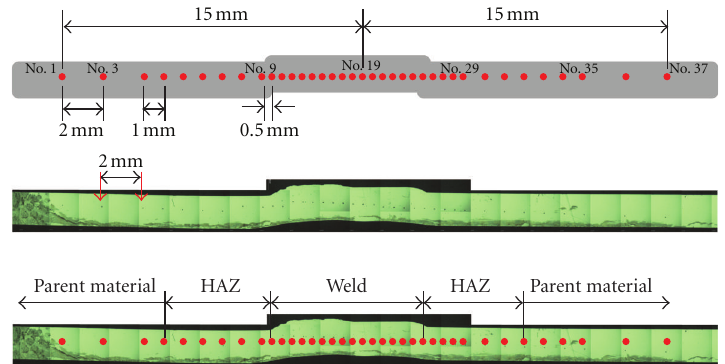
Figure 5: Indented position in a welded Hastelloy-X alloy strip